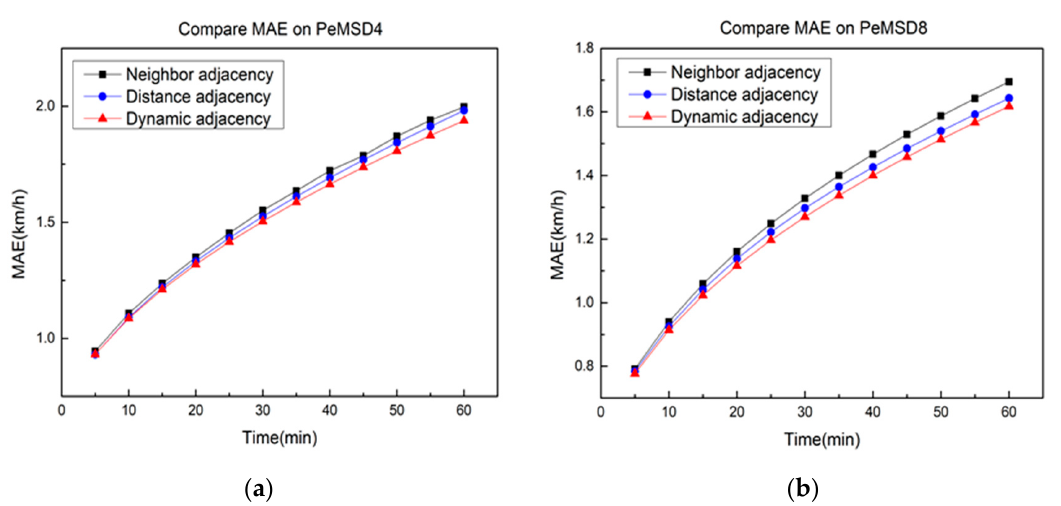
Figure 9. FSTGCN with different adjacency matrices. ( a ) PeMSD4. ( b ) PeMSD8.